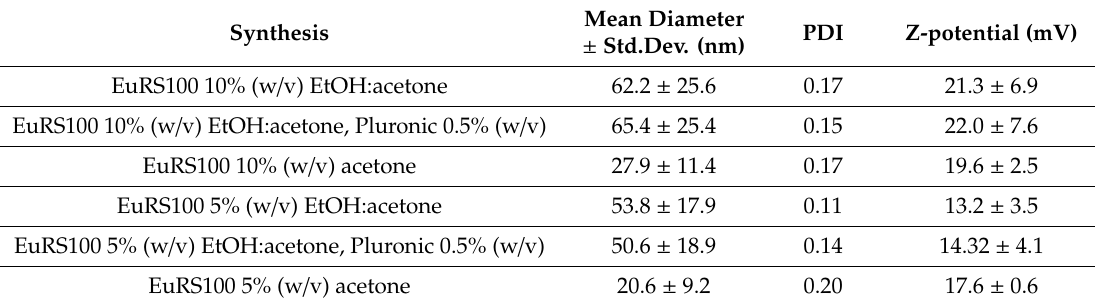
Table 4. Dynamic Light Scattering (DLS) and size mean and Z-potential (at pH 6) characterization of the synthesis obtained by the batch